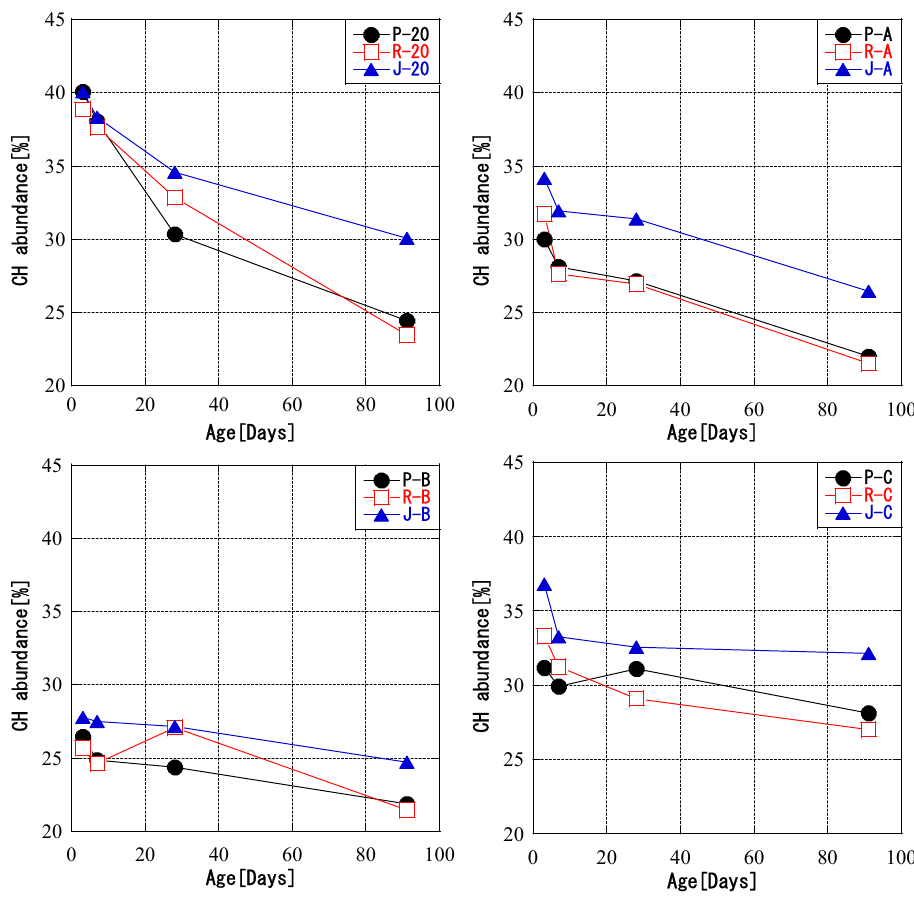
Figure 8. CH abundance.